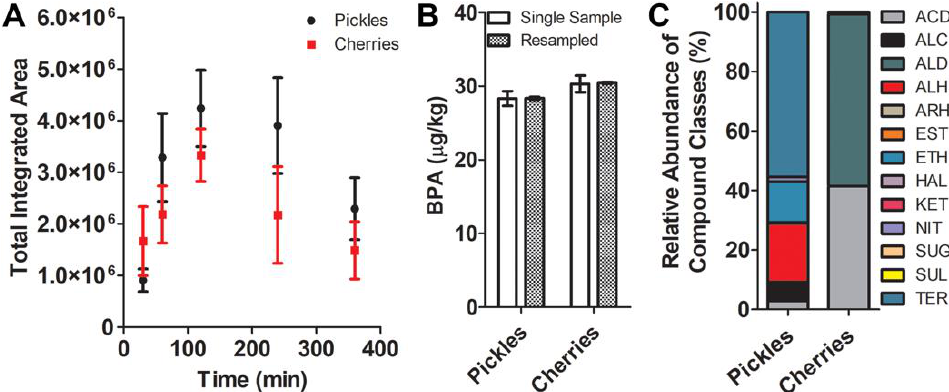
Figure 1. Validation of a solid-phase microextraction (SPME) method to assess the volatile inventories of preserved foods using commercially available dill pickles and maraschino cherries. A time course from 30 – 360 min of SPME sampling was conducted for both pickles (black circles) and cherries (red squares) in triplicate. Total integrated peak area is presented as the average ± standard deviation ( A ). As the 120 min (2 h) timepoint produced the greatest total integrated peak area for both preserved foods, the reproducibility of the sampling protocol was assessed based on the level of BPA measured following spiking 1000 μg into jars of pickles and cherries ( B ). Five jars each of pickles and cherries were sampled a single time, and three different jars of each food were sampled in three successive replicates. The concentration of BPA was determined by comparison to a standard curve and is presented as the average ± standard deviation for single samplings (clear bars) and average ± standard error of the mean for replicate samplings (dotted bars). The relative abundance of the assessed compound classes (as percent of total) is presented for the pickles and cherries sampled for 2 h with SPME ( C ). Compound classes are defined as follows: ACD = acids; ALC = alcohols; ALD = aldehydes; ALH = aliphatic hydrocarbons; ARH = aromatic hydrocarbons; EST = esters; ETH = ethers; HAL = halogen-containing; KET = ketones; NIT = nitrogen-containing; SUG = sugar alcohols; SUL = sulfur-containing; TER = terpenoids.